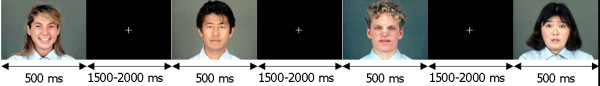
Stimulus sequence. Schematic diagram of a typical trial sequence of face stimuli used in explicit and implicit emotion processing tasks, with timing parameters as shown.